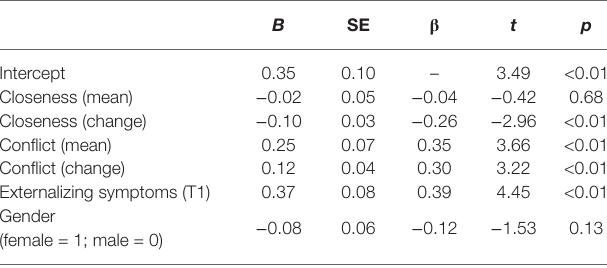
TABLE 6 | From middle to high school: T2 externalizing symptoms on student- teacher relationship scale variables ( N = 117; R 2 = 0.39).